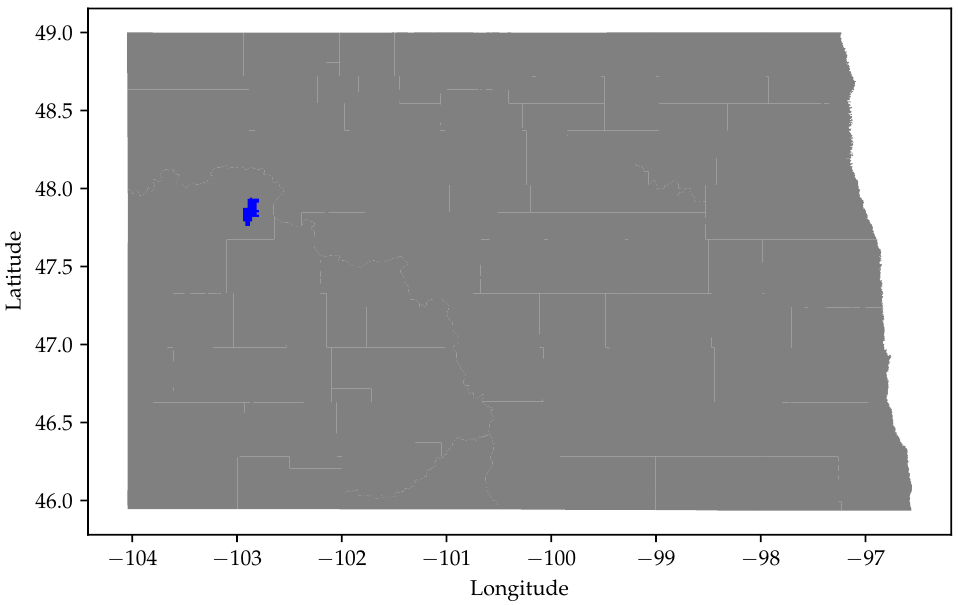
Figure 4. Location map of the Blue Buttes Field (highlighted in blue) in North Dakota, which is graphed using the information from the field